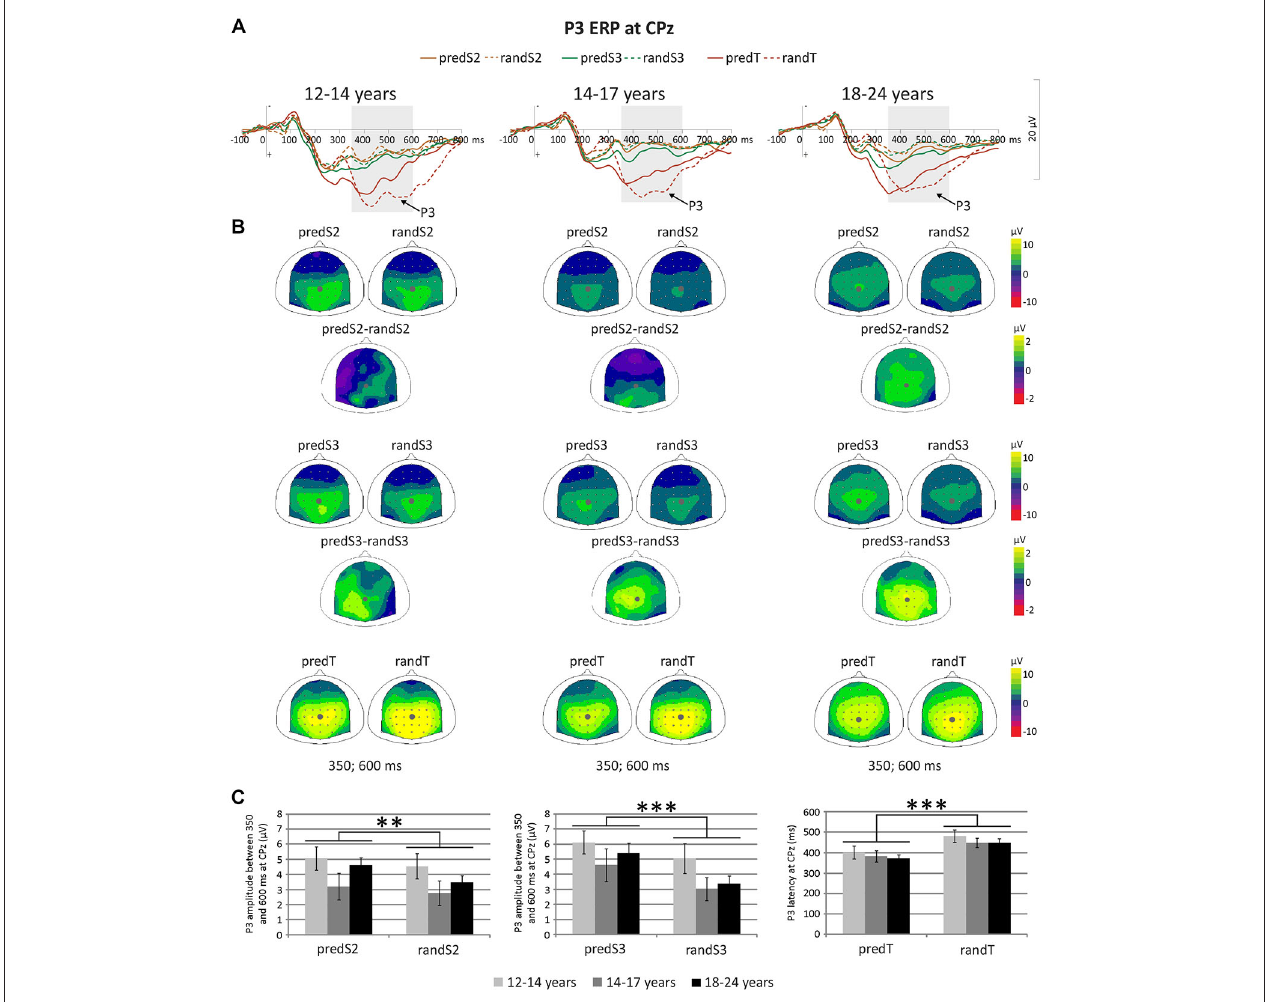
FIGURE 6 | Predictive processing: P3 ERP. (A) Grand-average ERP waveforms band-pass filtered between 0.5 and 30 Hz, at the CPz electrode. (B) Scalp topographies (top views) of the mean P3 ERP for each pair of predictive stimulus and its non-predictive analog, and for the difference between predS2 and randS2 and between predS3 and randS3 in the 350–600 ms time-window. The gray dots indicate the position of the Cpz electrode. (C) P3 amplitude between 350 and 600 ms in µ V at CPz for predS2 and randS2, and for predS3 and randS3. Maximum P3 latency in ms at CPz for predicted and random targets. Error bars: standard errors of mean. Significant differences are indicated by asterisks: ∗∗ p ≤ 0.01, ∗∗∗ p ≤